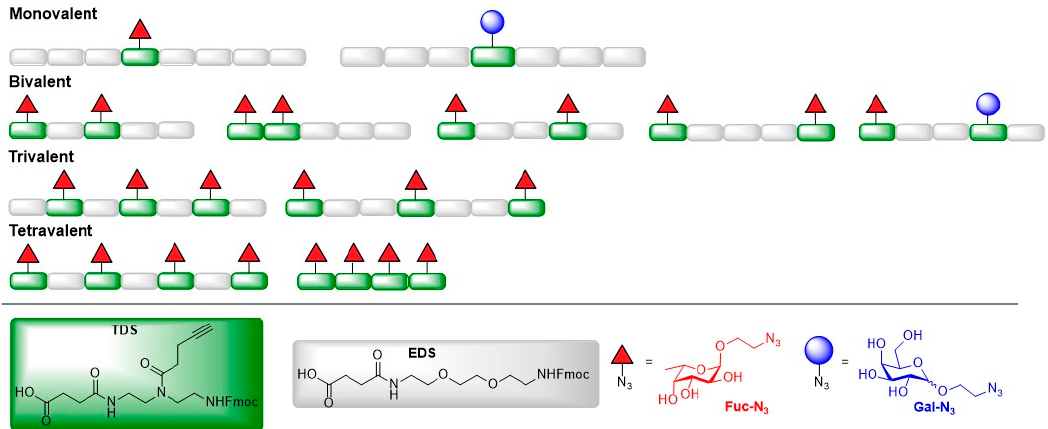
Figure 17. Structure of building blocks TDS and EDS and fucosylated glycooligomers.